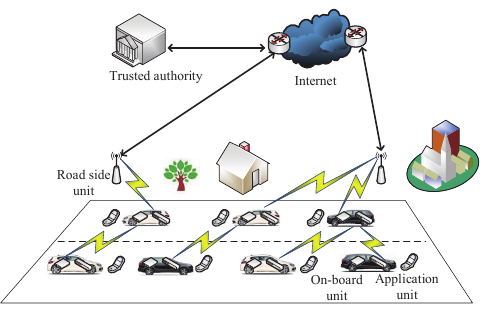
Figure 3. A framework of vehicular ad hoc networks (VANETs).